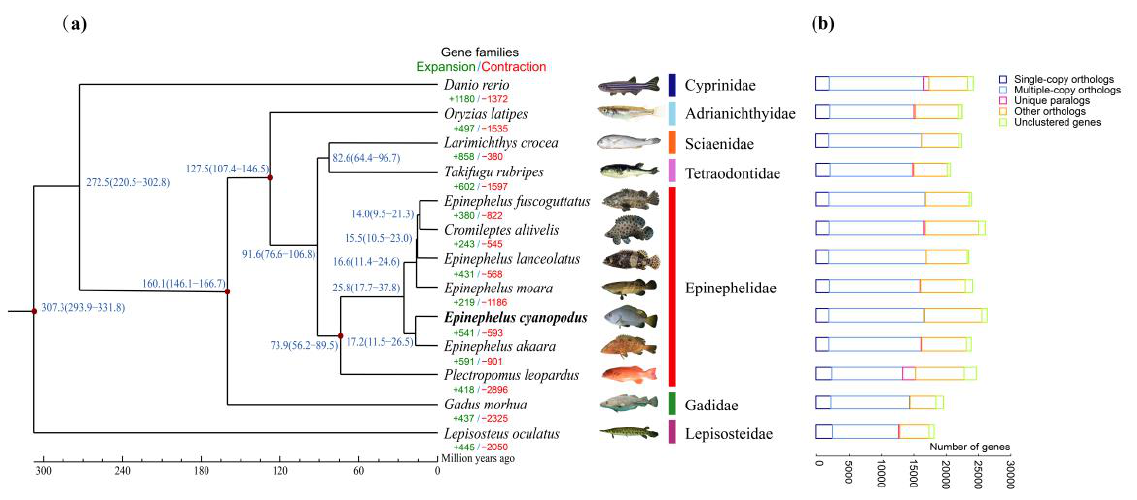
Figure 3. Comparative genomic analysis visualization of E. cyanopodus and 12 teleost fishes: ( a ) phylogenetic tree and divergence time constructed for 13 selected species. The blue numbers on the branches indicate the estimated divergence times (million years ago; confidence intervals 95%). The number represents the number of expanded (green) and contracted (red) gene families; and ( b ) comparison of gene family clusters. The horizontal axis display genes number and the vertical axis display species.